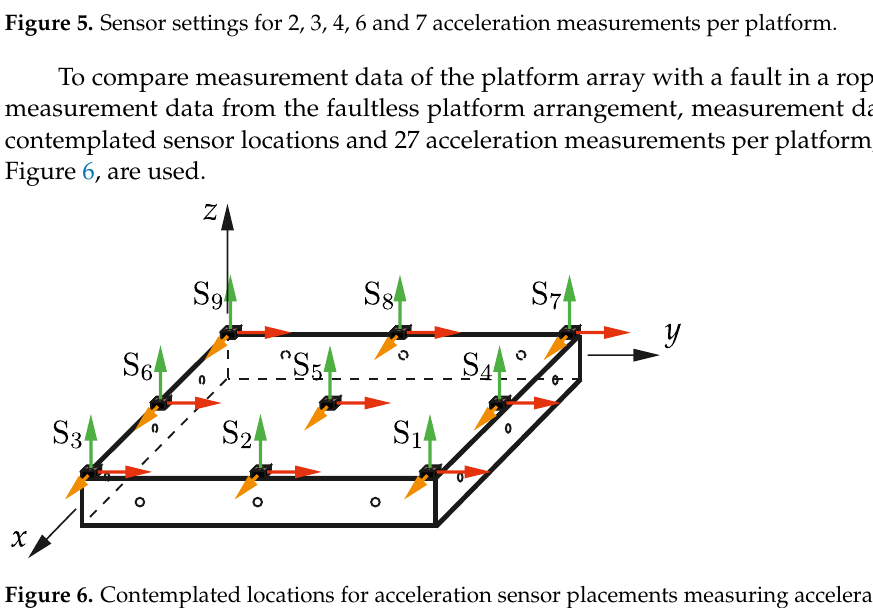
Figure 6. Contemplated locations for acceleration sensor placements measuring accelerations in x , y and z